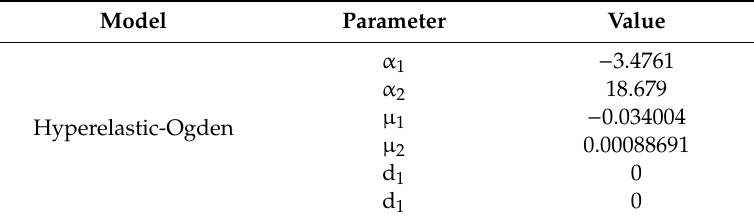
Table 2. Parameters of the second-order Ogden model.